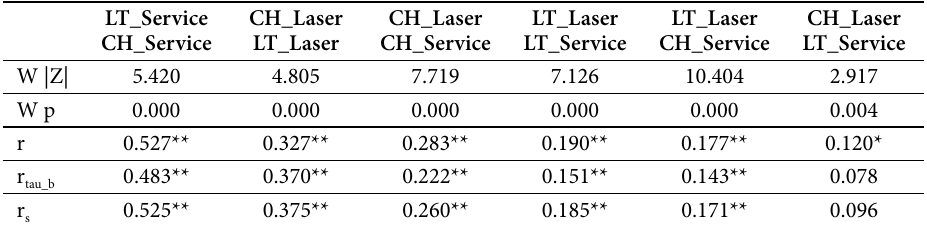
Table 4. Correlation analyses and Wilcoxon tests: comparison of the innovation